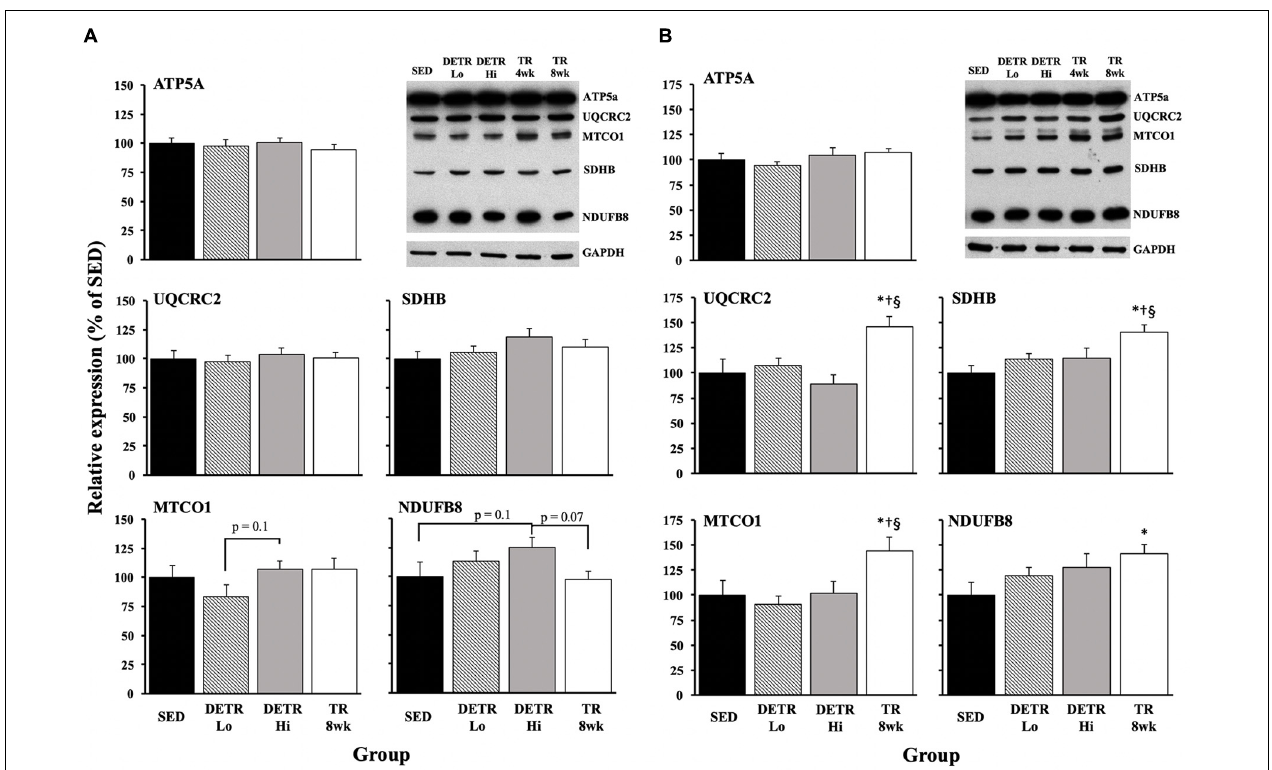
FIGURE 5 | Mitochondrial protein expression in SED, detrained (DETR), and trained (TR) soleus (A) and plantaris (B) muscles of adult female rats. DETR consisted of 4 weeks of voluntary running followed by 4 weeks of SED conditions and were categorized as high- (DETR Hi) or low- (DETR Lo) total running distances. Exercise-trained rats ran for 8 weeks (TR 8wk). Representative blots for OXPHOS and GAPDH proteins are shown (upper right) for soleus and plantaris muscles for all groups, including samples from TR 4wk rats (group results presented in Table 2 ). Values are means ± SEM. Significant differences from SED ( ∗ ), DETR Lo ( † ), and DETR Hi ( § ) are indicated; significance was set a p <